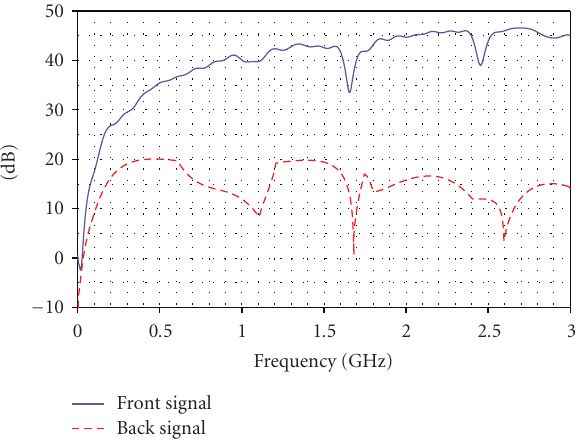
Figure 4: The antenna array.